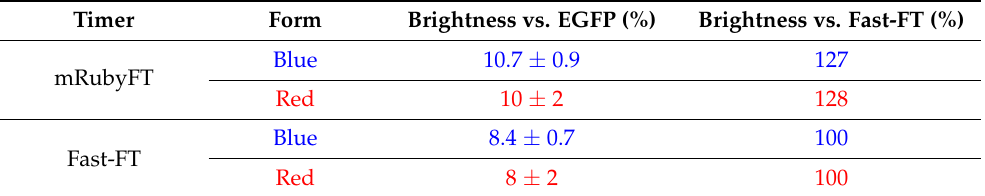
Table 2. Comparison of the brightness of the mRubyFT timer derived from mRuby2 protein and the mCherry-based Fast-FT timer transiently expressed in HeLa mammalian cells. The blue and red font color reflects the fluorescence color of the respective blue and red form. Timer Form Brightness vs. EGFP (%) Brightness vs. Fast-FT (%) Blue 10.7 ± 0.9 127 mRubyFT Red 10 ± 2 128 Blue 8.4 ± 0.7 100 Fast-FT Red 8 ± 2